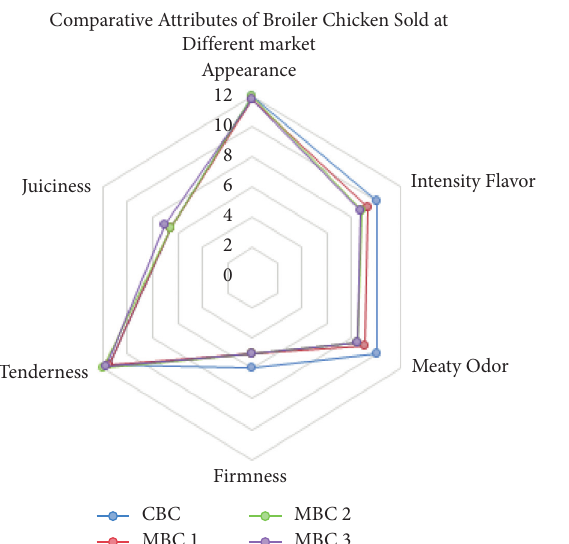
Figure 5: Spider plot of comparative attributes of broiler chicken sold at different markets. CBC, control broiler chicken; MBC, market broiler chicken. Table 15: Comparative attributes between control colored chicken (CCC) and market colored chicken (MCC) sold at the market.